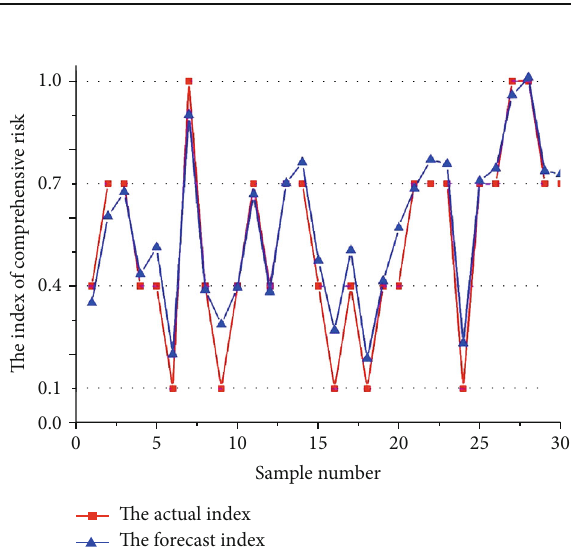
Figure 2: Comparison of forecast results and actual